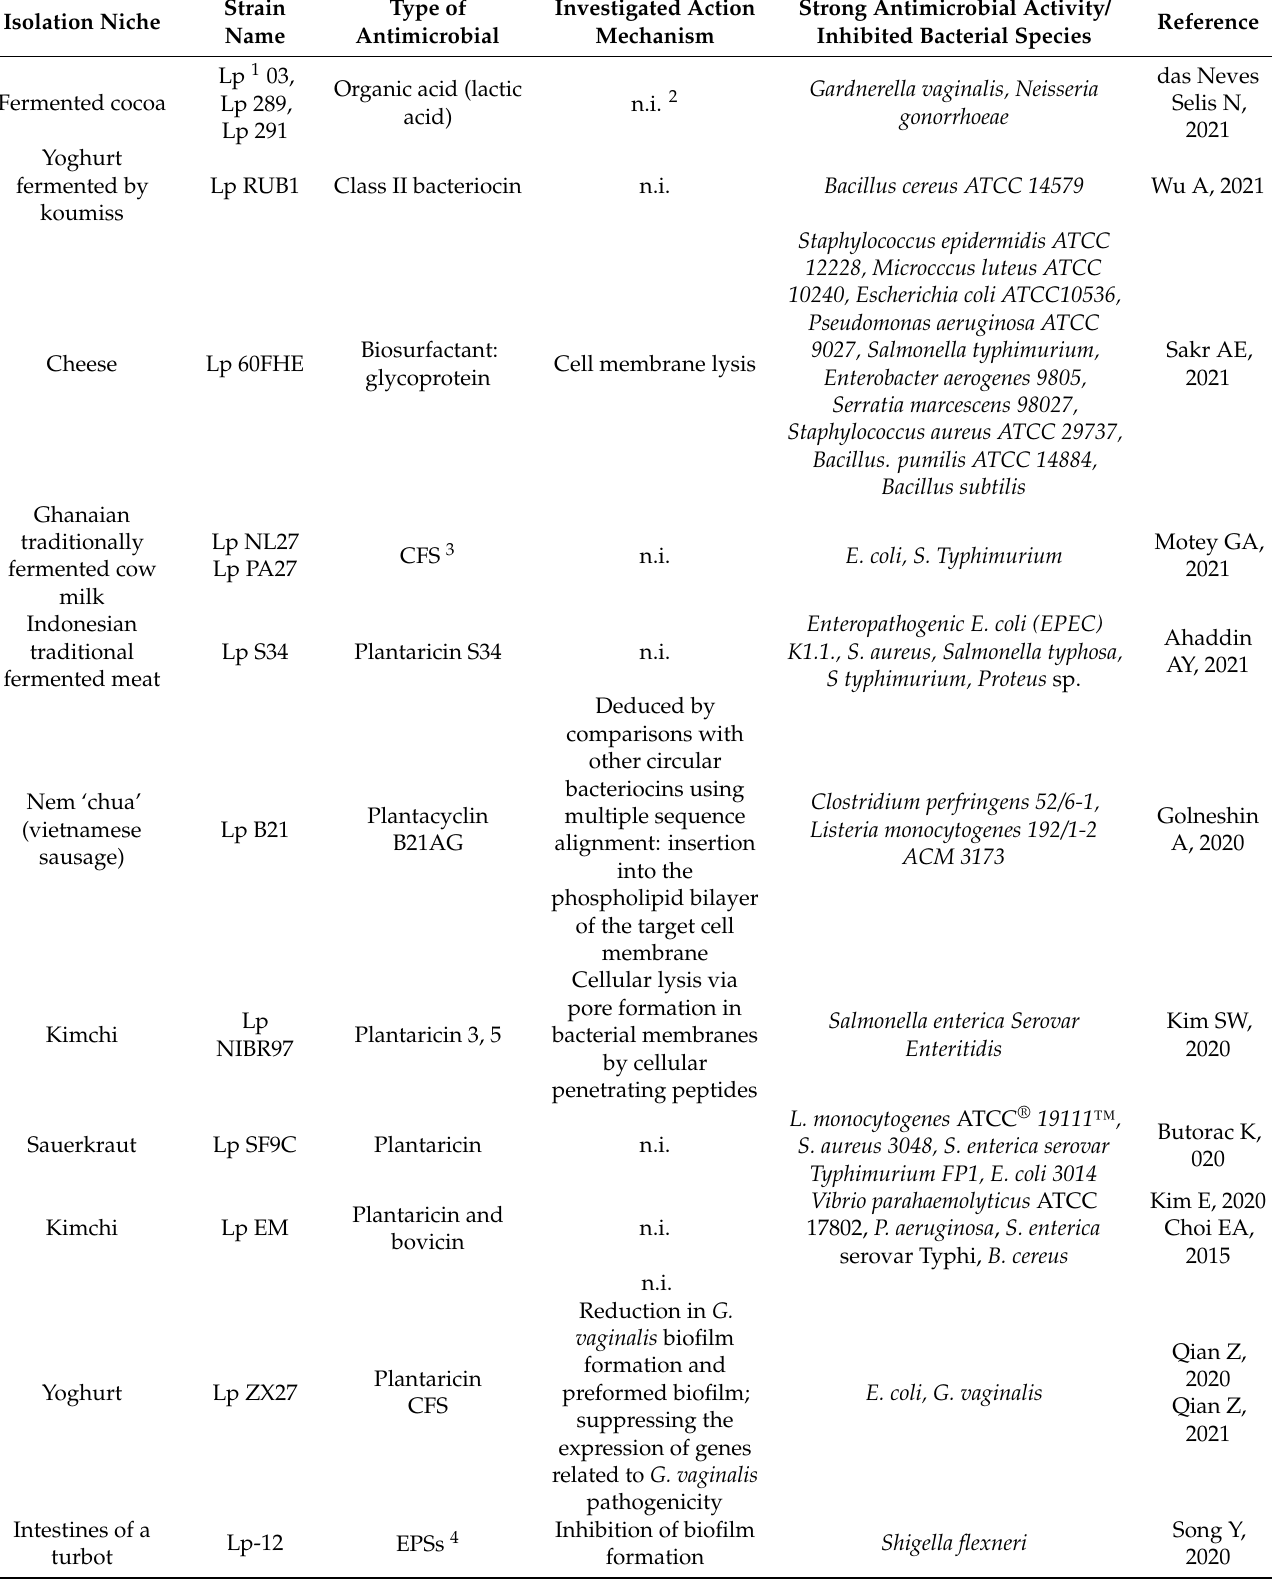
Table 1. Probiotic L. plantarum strains with documented in vitro antibacterial